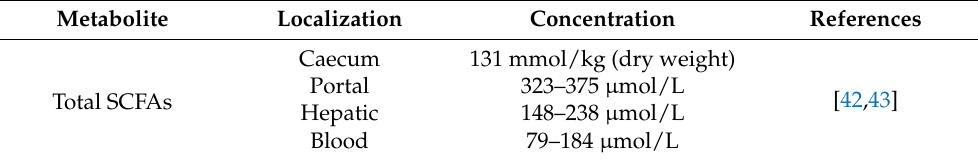
Figure 1. General structures of metabolites produced by gut microbiota and known effects on immune responses. Green arrow: upregulation, Red arrow: downregulation. Cell population: cells activated by metabolites. T cell: T lymphocyte, Treg: regulatory T lymphocyte, B cell: B lymphocyte, Neu: netrophil, Mon: monocyte, MP: mononuclear phagocyte, DC dendritic cell, EP: endothelial cells, EC: epithelial cells, Foxp3+ Treg: regulatory T lymphocyte Foxp3+, pDC: plasmacytoid dendritic cells, iNKT: invariant natural killer T cells. Table 1. SCFA levels in humans.